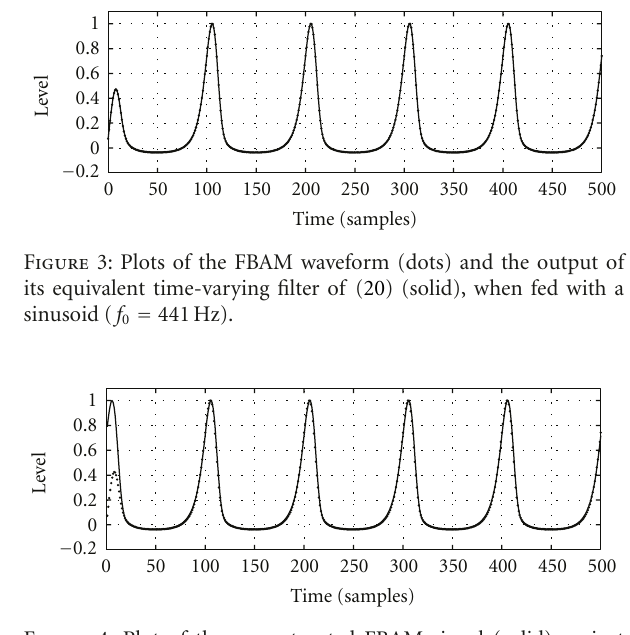
Figure 4: Plot of the reconstructed FBAM signal (solid) against the actual FBAM waveform (dots), with f 0 = 441Hz. The reconstruction is based on the steady-state spectrum and thus does not include the transient e ff ect seen at the start of the FBAM